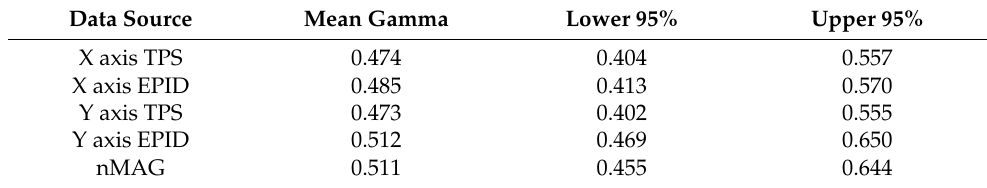
Table 2. Gamma evaluation results of experimentally (NMR evaluation) obtained dose